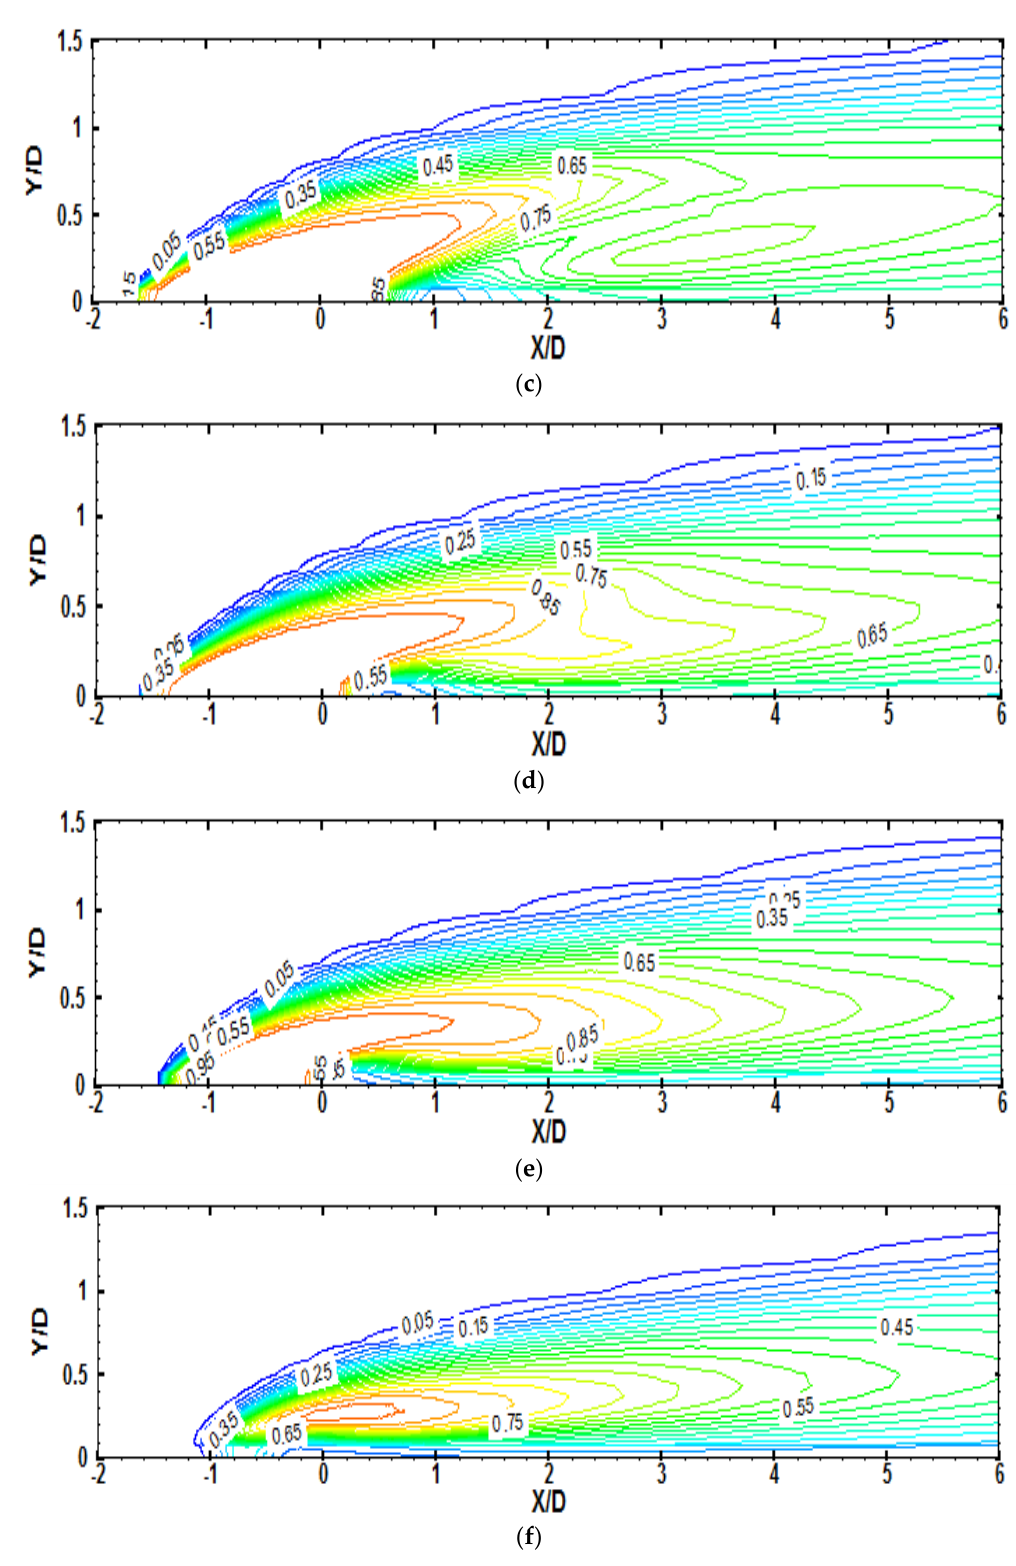
Figure 12. The temperature contours downstream of the cooling duct hole. ( a ) Temperature contours θ at different span-wise planes right above the cooling duct hole; ( b ) θ at Z/D = 0, the hole centerline; ( c ) θ at Z/D = 0.125; ( d ) θ at Z/D = 0.25; ( e ) θ at Z/D = 0.375; ( f ) θ at Z/D = 0.5, near the hole edge.